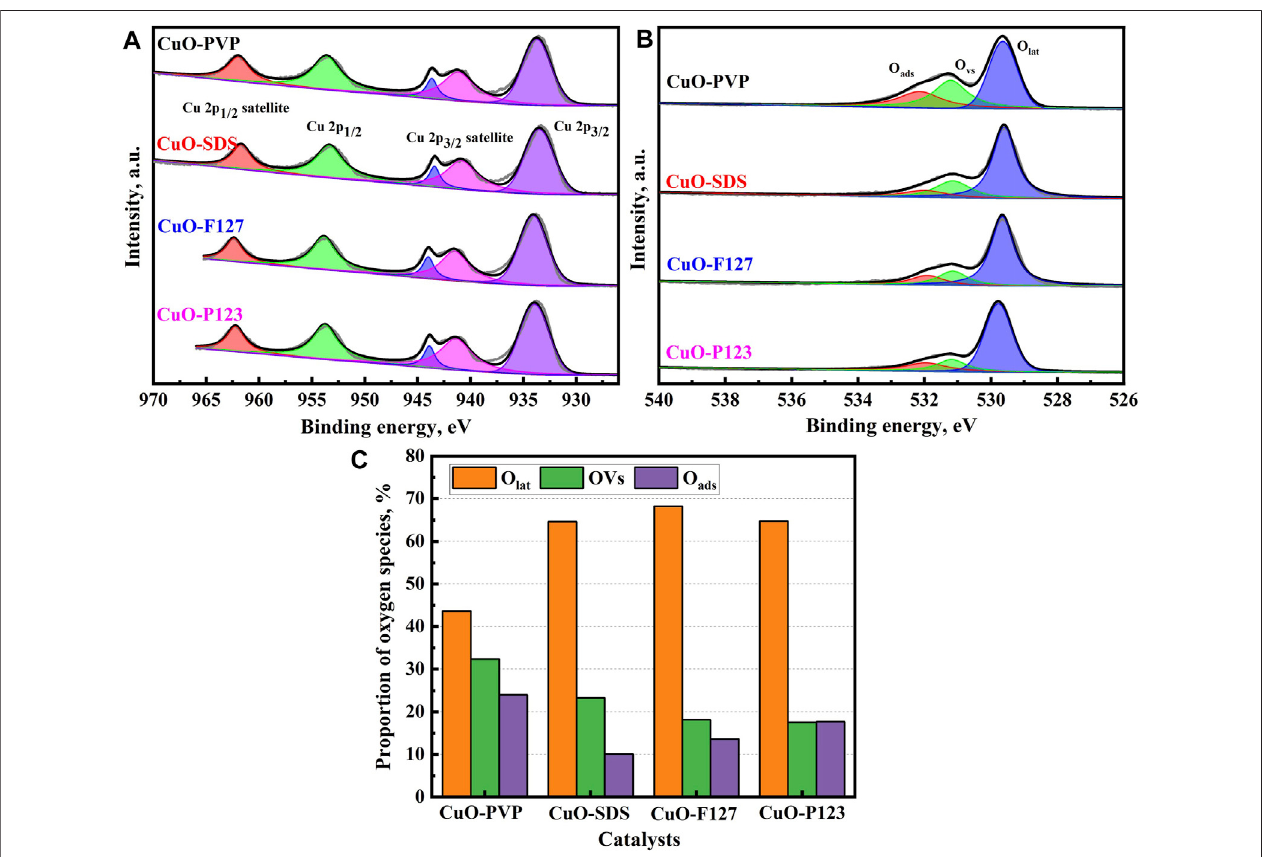
FIGURE 3 | XPS pro fi les of the CuO catalysts synthesized with different templates. (A) Cu 2p; (B) O 1s; (C) distribution of oxygen species.